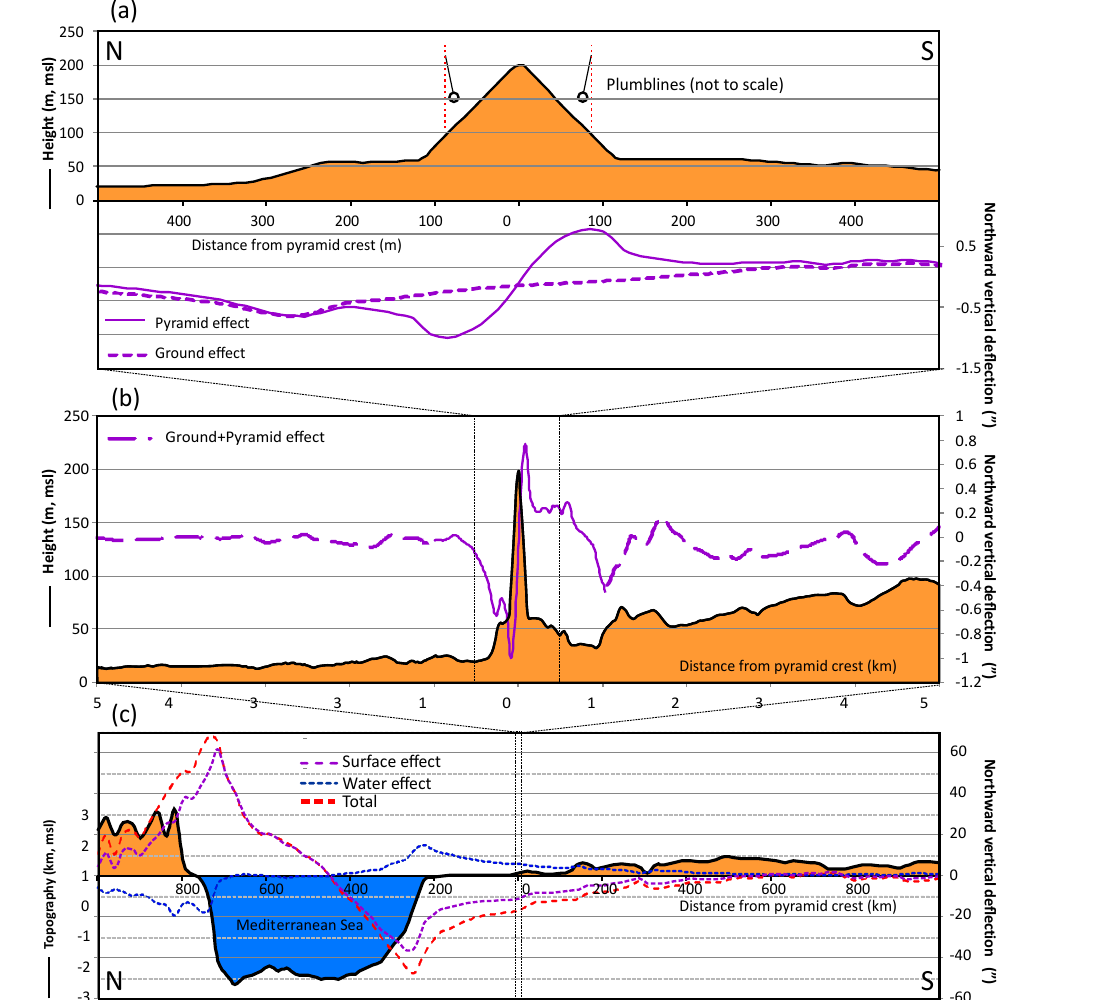
Figure 2. North–south profile of topography and computed northward deflection of the vertical through the Great Pyramid. Location shown in Fig. 1. (a) 1km section. The summed inward deflection between the northern and southern flanks of the pyramid is 1.8arcsec. The component of the deflection of the vertical caused by the surrounding ground topography is indicated with the dashed line. The pyramid continues to cause a difference in deflection of the vertical greater than about 0.1arcsec for a distance of about 300m from its peak. (b) 10km section. More regionally, the deflection of the vertical in a north–south direction is greatest on the pyramid’s faces, but the topography also causes variations up to about 0.3arcsec. (c) 2000km section. Regional effect of the surface and Mediterranean Sea. Here densities of 1050 and 2500kmm − 3 have been used for water and topography respectively. The strongest deflections of the vertical (red trough and peak at 700 and 250km N on the profile) are associated with the relatively sharp changes in bathymetry on the margins of the sea. A deflection of the vertical of about 11arcsec south is calculated at Giza, largely due to the lateral topographic and density contrast between the water body of the Mediterranean Sea and the topography of southern Egypt, though the difference between the stations on the pyramid flanks is